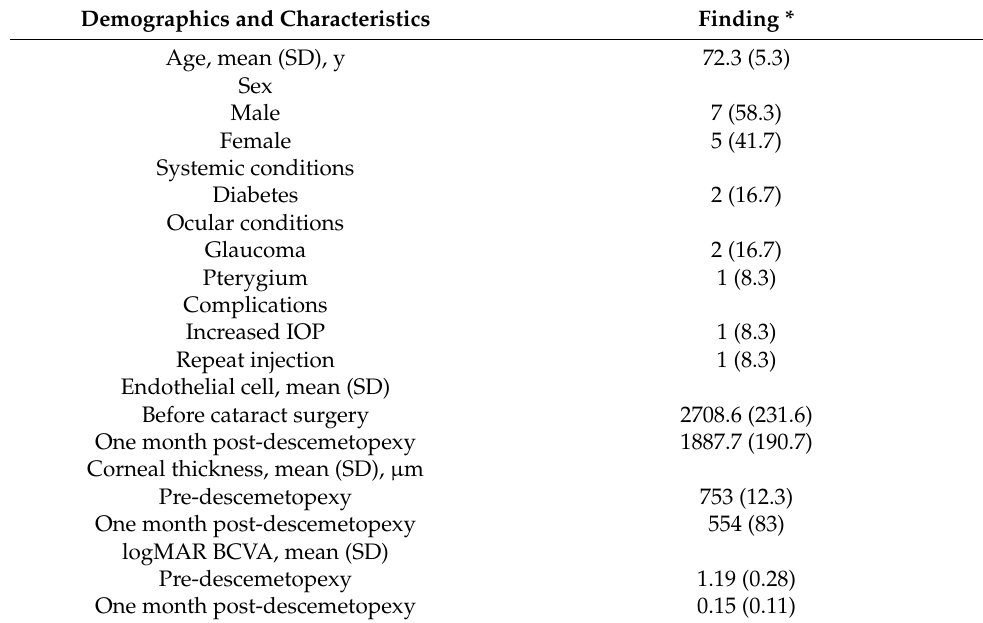
Table 1. Patient Demographics and